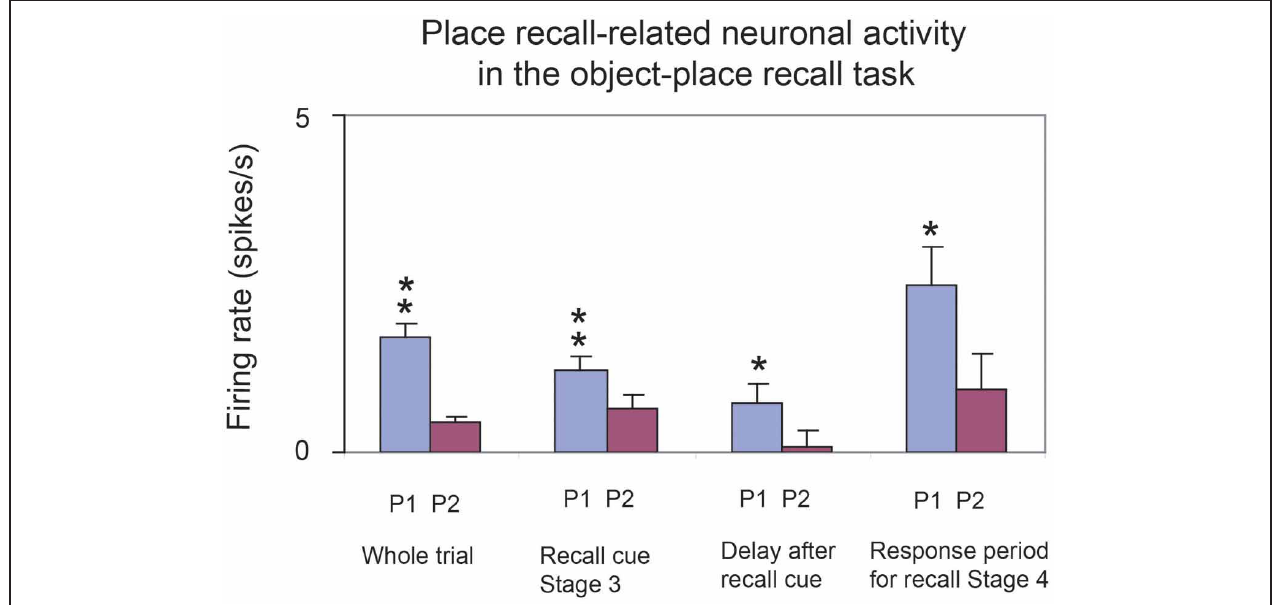
period after one of the objects had been shown in stage 3 as the recall cue. The neuron responded more when place 1 was the correct place to be recalled on a trial. The fourth histogram pair shows the neuronal responses in stage 4 when the macaque was recalling and touching the place at which the cue recall object had been shown. The responses of the neuron were place-related even in stage 3 when the object being shown as a place recall cue was at the top of the screen, in the delay after stage 3 of the task, and in stage 4. ∗∗ p < 0 . 01; ∗ p < 0 . 05 [After Rolls and Xiang (2006)].